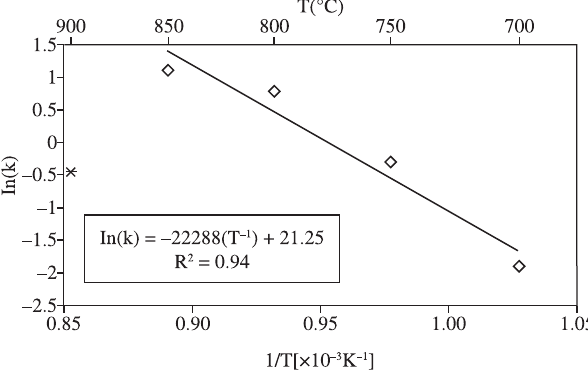
Figure 12. Plot for determination of activation energy for both nucleation and growth of sigma from ferrite (Q (k ), in temperatures between 700 and 850 °C. o